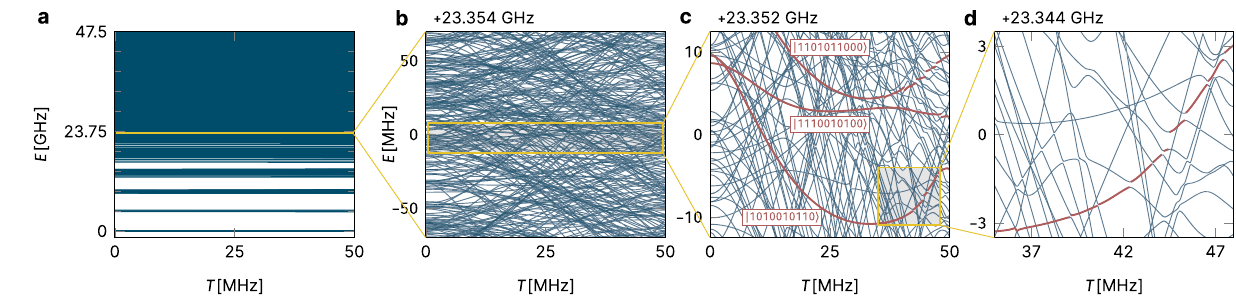
Fig. 2 Energy spectrum of a coupled transmon array. Illustrated are the energy levels E α ( T ) of Hamiltonian Eq. (1) on varying energy scales; the data shown is for a coupled transmon chain of length N = 10. Panel a illustrates the clustering of levels into energy bundles corresponding to the total number of bosonic excitations. Panel b zooms into the fi ve-excitation band, which upon further enlargement in panel c reveals level repulsions that become particularly visible for larger couplings. In panel c we also mark in red a number of computational states (identi fi ed in this energy window at vanishing coupling T = 0). The further zoom-in of panel d traces one such computational state through a sequence of avoided level